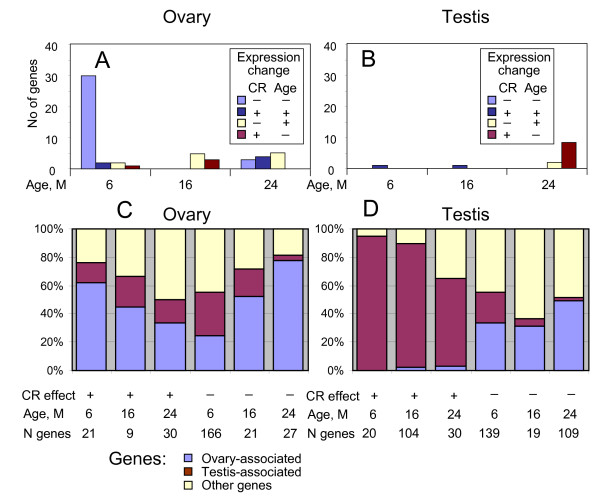
Age-specific effect of diet (AL versus CR). (A), (B) Numbers of age-dependent genes which were also affected by diet at specific age from 6 to 24 months in ovary and testis, respectively. (C), (D) Proportion of genes that were over-expressed either in ovary or testis, respectively, by at least two-fold among genes that were increased or decreased by CR at specific age from 6 to 24 months.